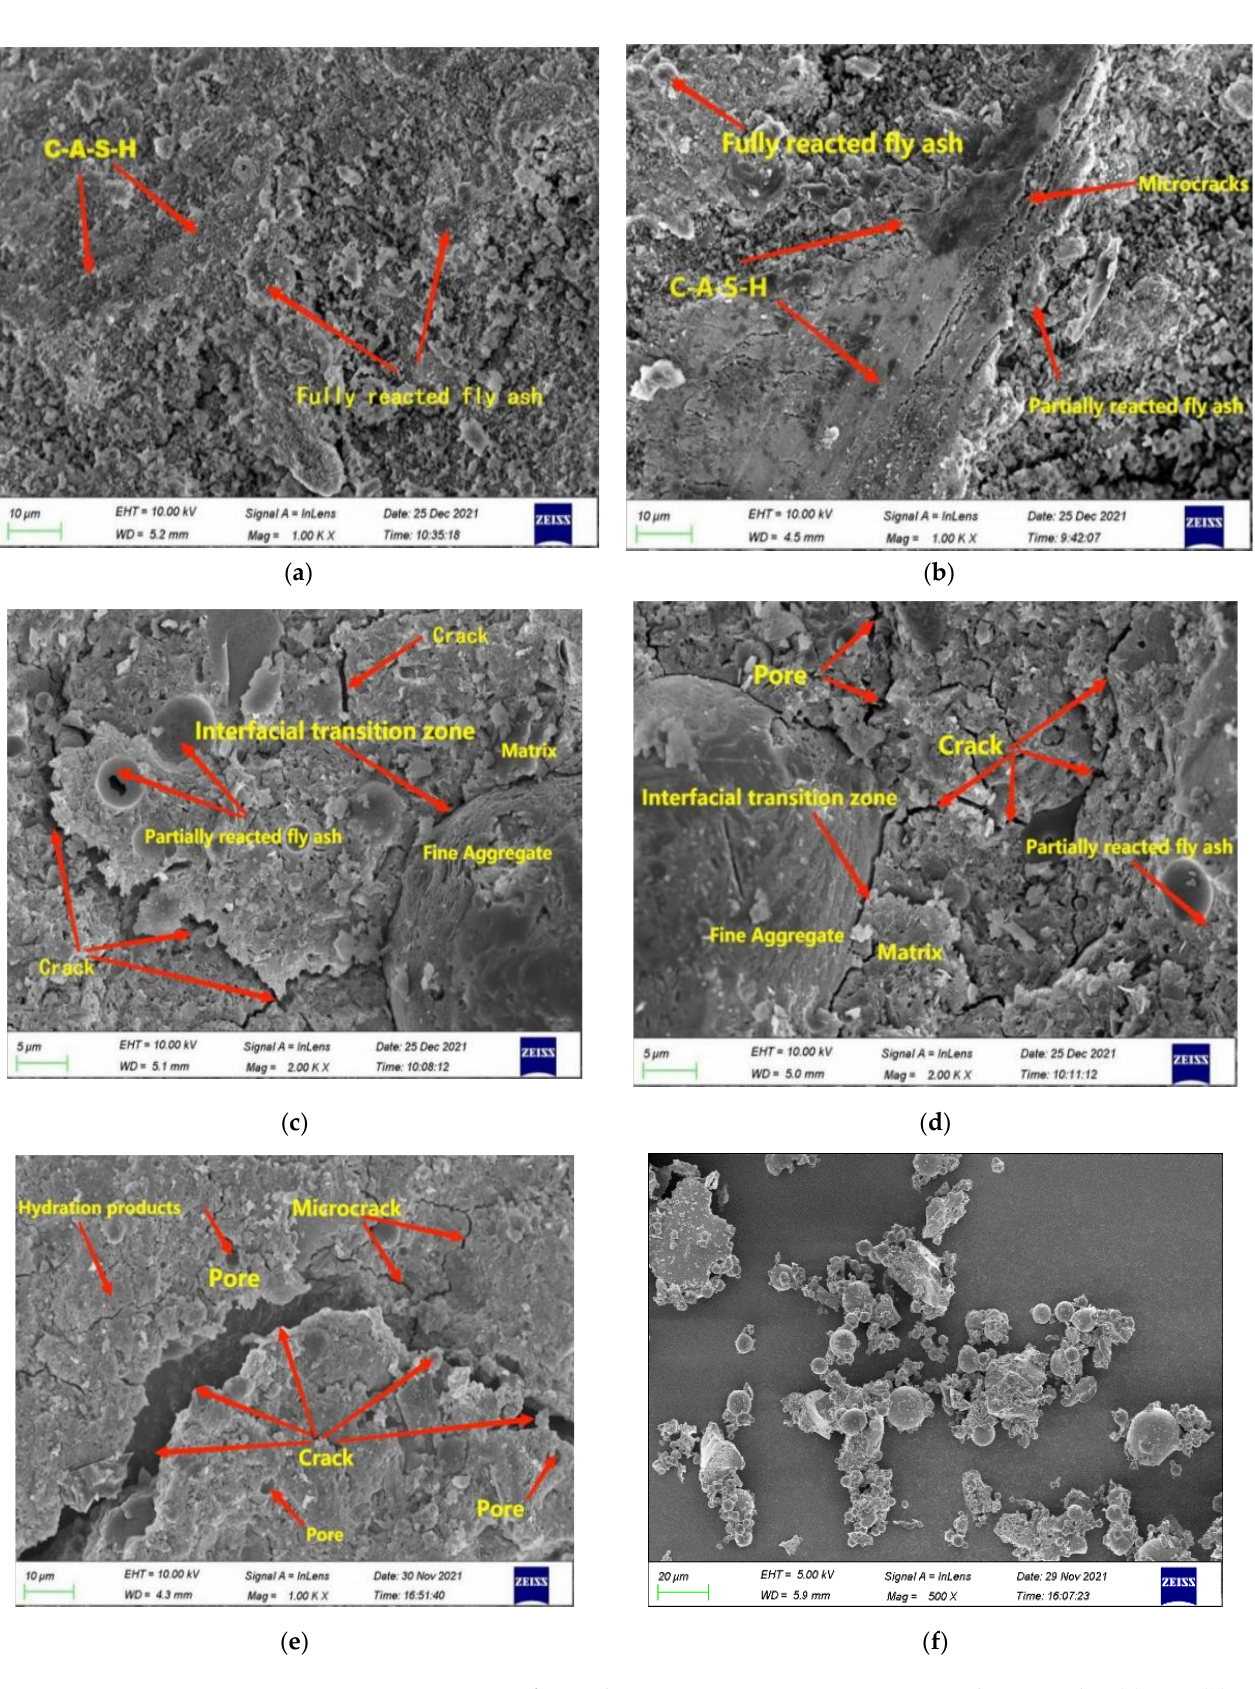
Figure 4. SEM images of geopolymer mortar containing MSWIFA and FA particles. ( a ) S ‐ 00, ( b ) S ‐ 05, ( c ) S ‐ 15, ( d ) S ‐ 25, ( e ) S ‐ 35, ( f )